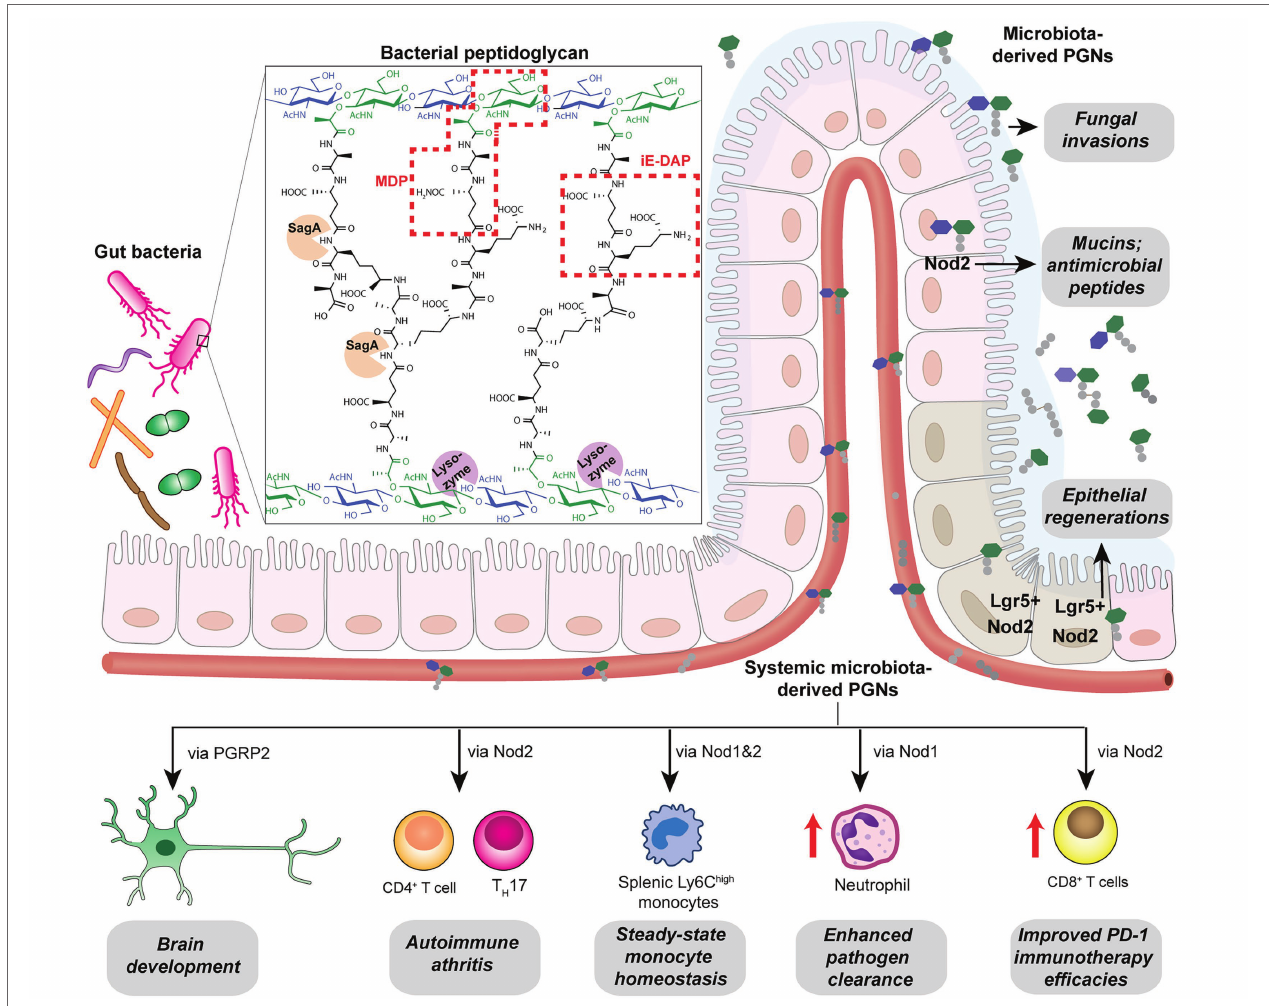
FIGURE 3 | Gut microbiota-derived peptidoglycan fragments (PGNs) in the host gut niche as well as in systemic circulation act to modulate host homeostasis in multiple